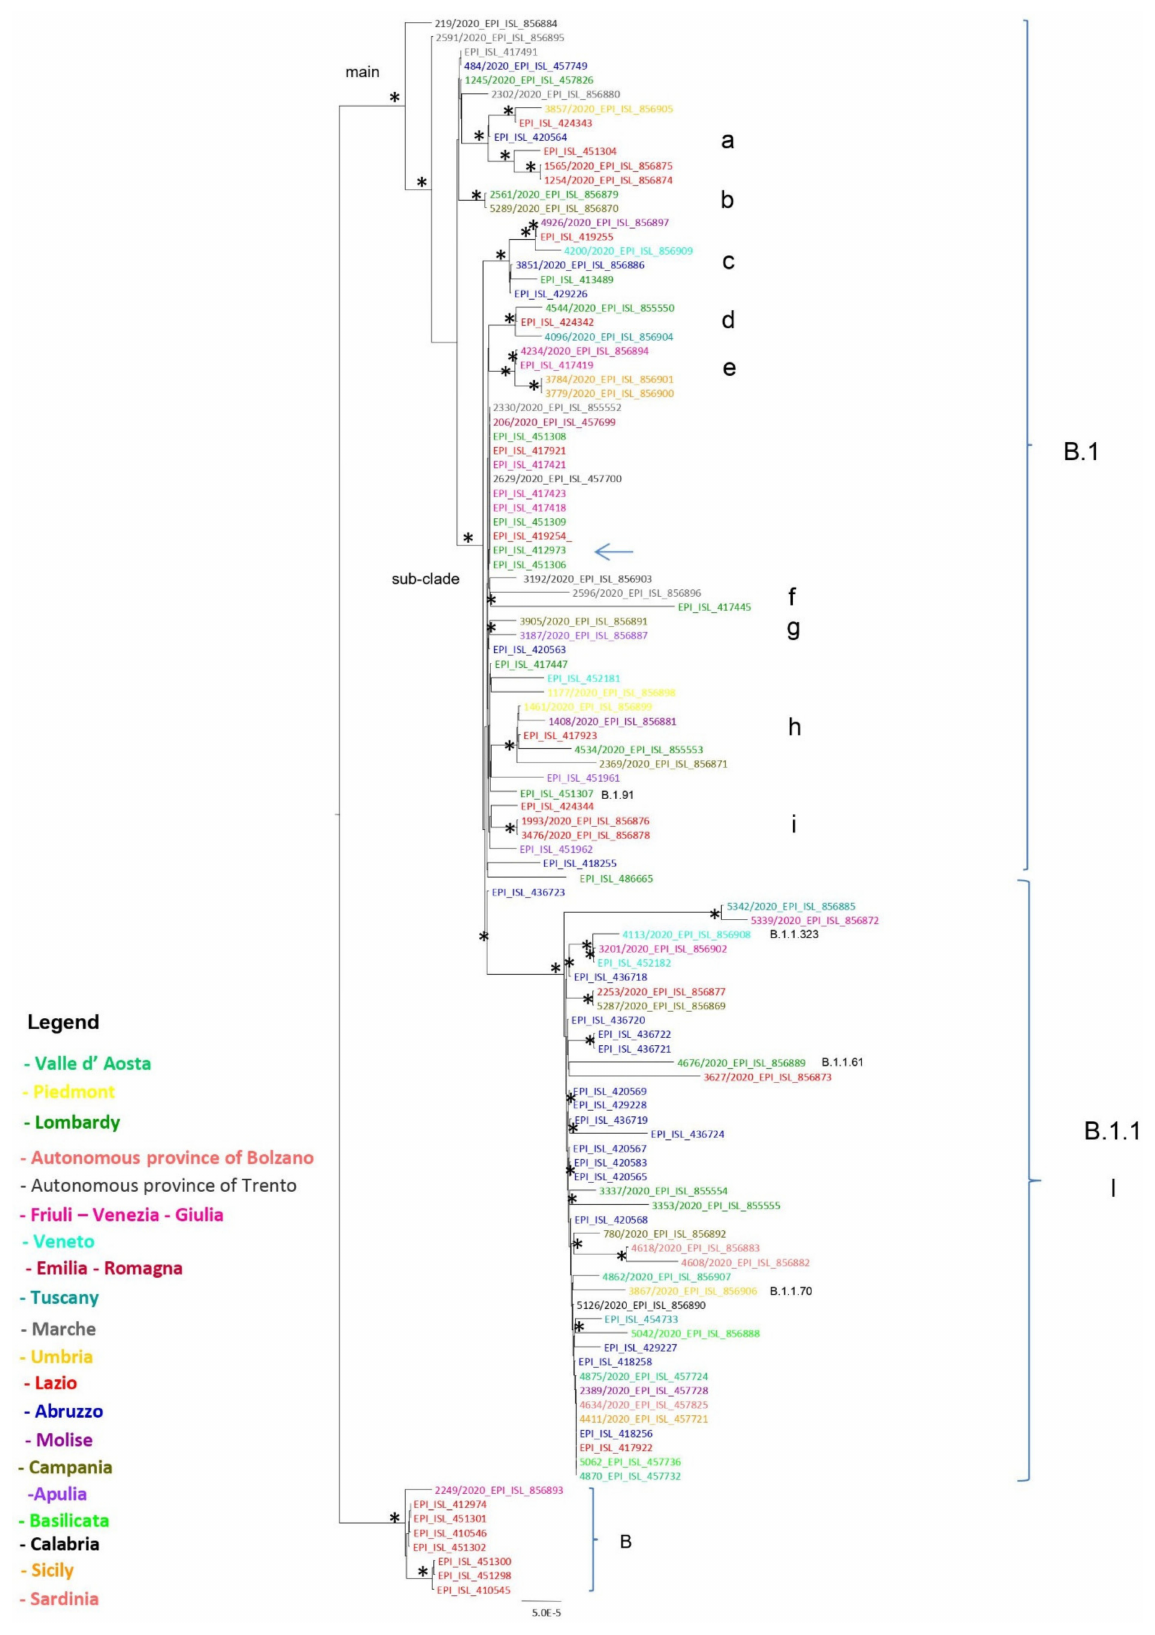
Figure 1. Maximum likelihood phylogenetic analysis of 58 SARS-CoV-2 Italian genomes from